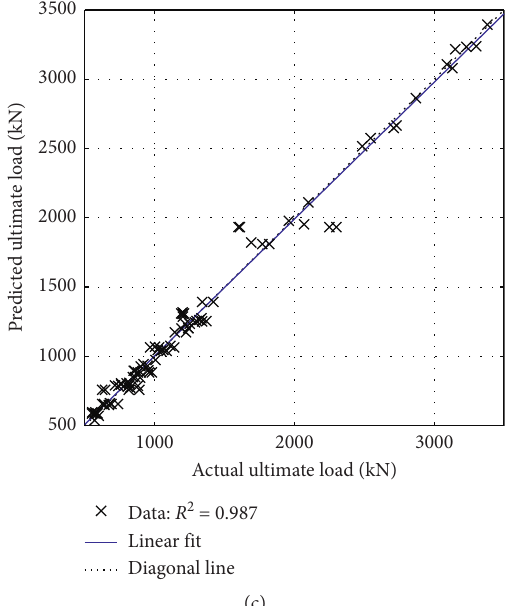
Figure 6: Regression between actual and predicted ultimate load: (a) using training data, (b) using testing data, and (c) using all data, for one case in 11-cross